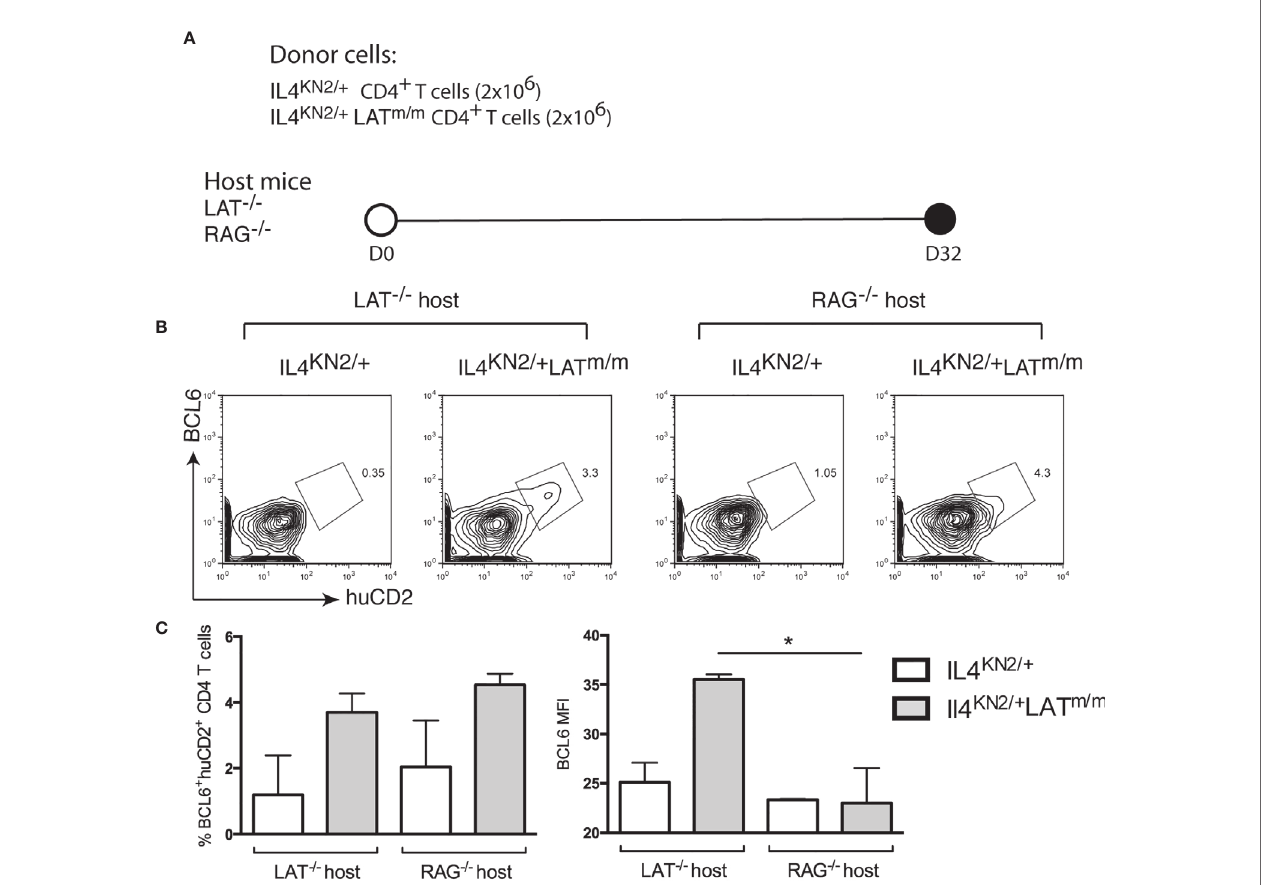
FIGURE 5 | B cells are important for maintaining BCL6 expression in Tfh cells. (A) 2x10 6 CD4 + T cells were sorted from 8 week-old IL4 KN2/+ and IL4 KN2/+ LAT m/m mice. Cells were i.v injected into LAT -/- or RAG -/- recipient mice for 8 wks. (B) BCL6 and huCD2 expression on CD4 + Thy1.2 + transferred T cells. (C) The percent of BCL6 + huCD2 + cells and intensity of BCL6 staining. Data are representative of 2-3 individual experiments. Two-tailed t test; *p <